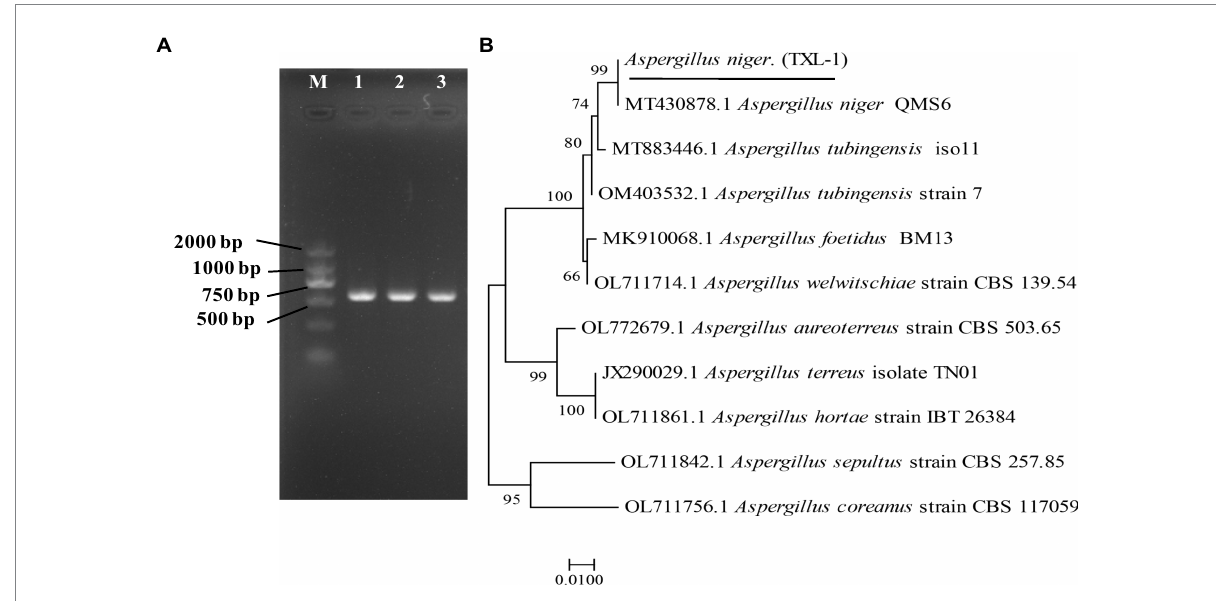
FIGURE 4 Molecular identification of fungal strains. (A) PCR results of the pathogen using DNA-ITS; (B) phylogenetic tree based on ITS sequences; (M) marker DL2000; (1, 2, 3) three